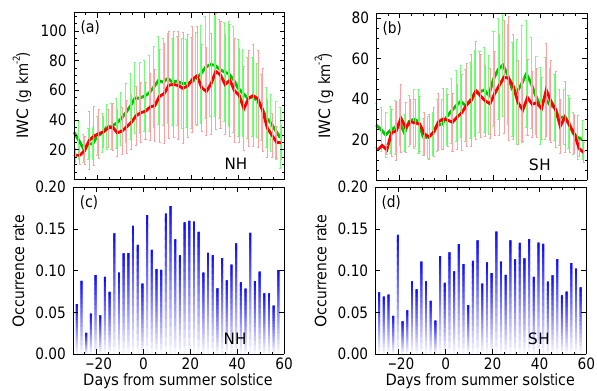
Figure 4. IWC averaged by 2 days for double-layer PMCs (red) and single-peak PMCs (green) in the NH (a) and SH (b) respec- tively. Error bars denote 1 standard deviation. Occurrence rates of double-layer PMCs as a fraction of all PMC events by 2-day inter- vals through the NH and SH seasons are shown in (c) and (d) .